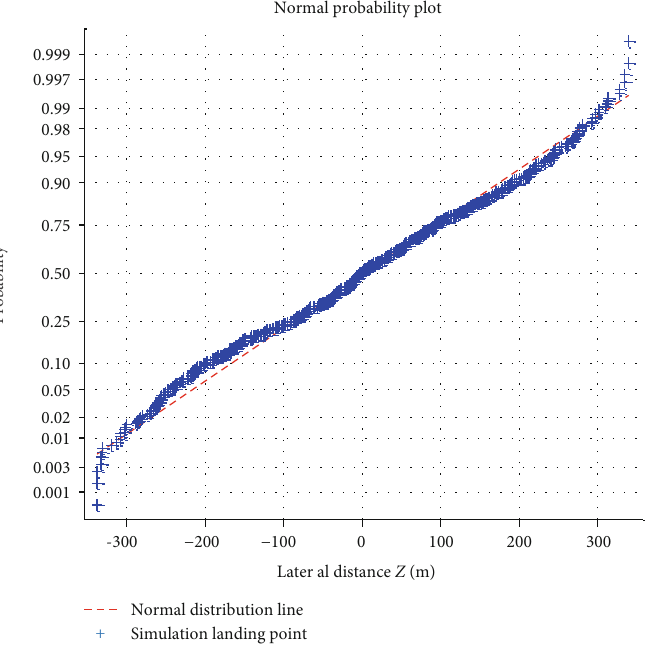
Figure 11: Fall point lateral coordinate normality